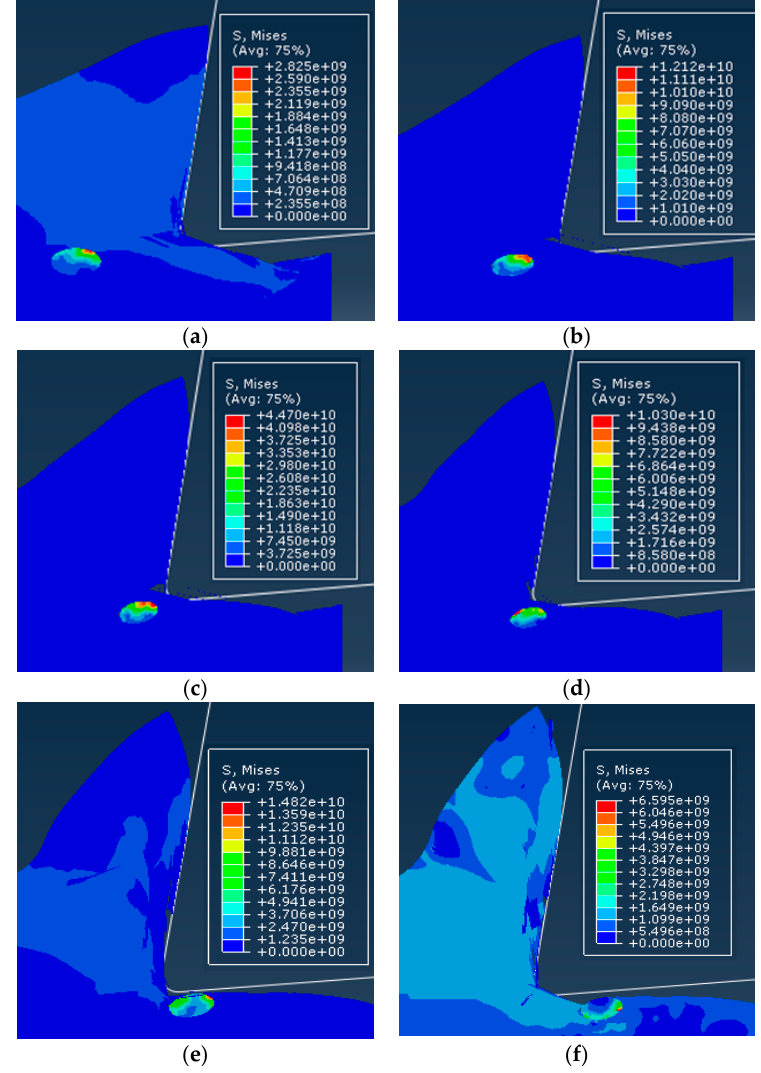
Figure 19. Simulation of the cutting process while the particles are below the cutting path: ( a ) Increased force above the particle, ( b ) movement of the particle, ( c ) partial separation of the particle, ( d ) broken of particle, ( e ) increased particle breakage areas, and ( f ) particle pressed into the matrix. Materials 2020 , 13 , x From the cutting process, it can be seen that the failure of the particles located below the cutting path was mainly the brittle fracture of the particles and the partial peeling of the particles from the matrix. Due to the pressing action of the tool, the particles were often pressed into the matrix, as shown in Figure 20, and after the cutting, a certain rebound occurred with the deformation of the matrix.